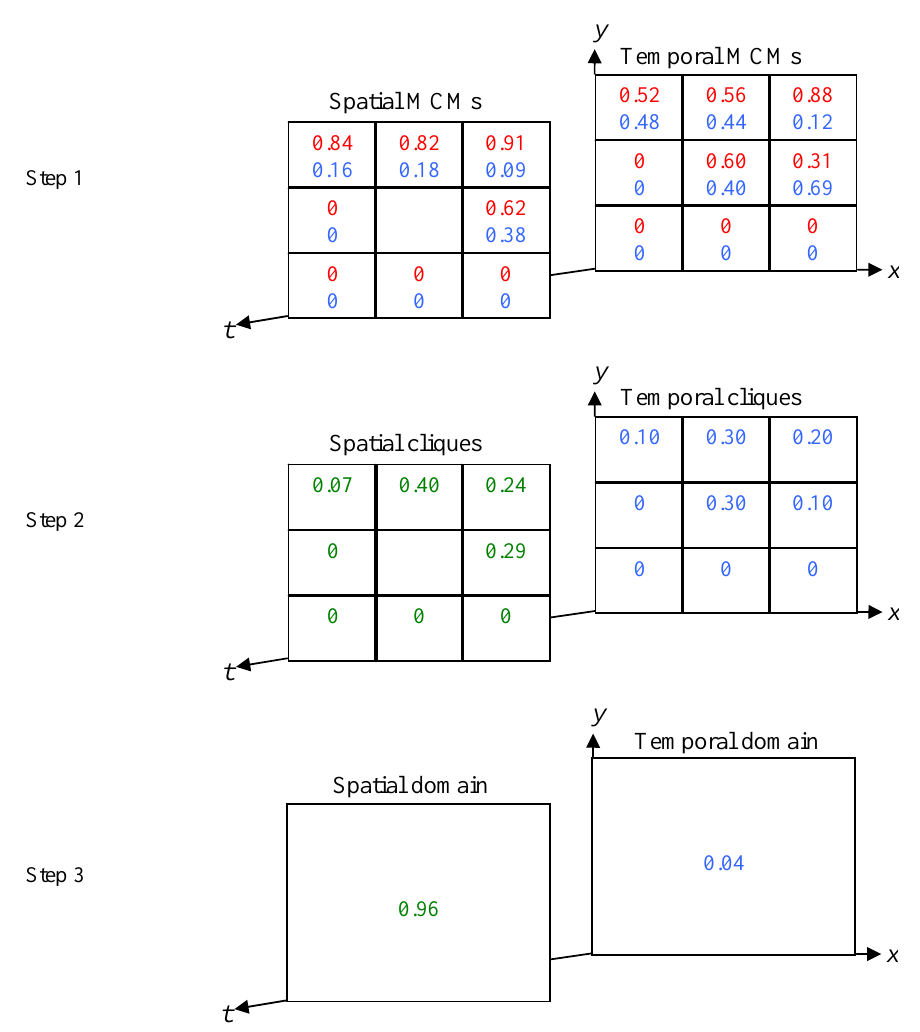
Fig 6: Feature weights obtained using the HFW approach –– Step1: Along each clique weight of magnitude and direction MCMs are marked in red and blue respectively; Step2: Spatial and temporal clique weights are marked in green and blue respectively, and Step3: Spatial and temporal domain weight marked in green and blue respectively.